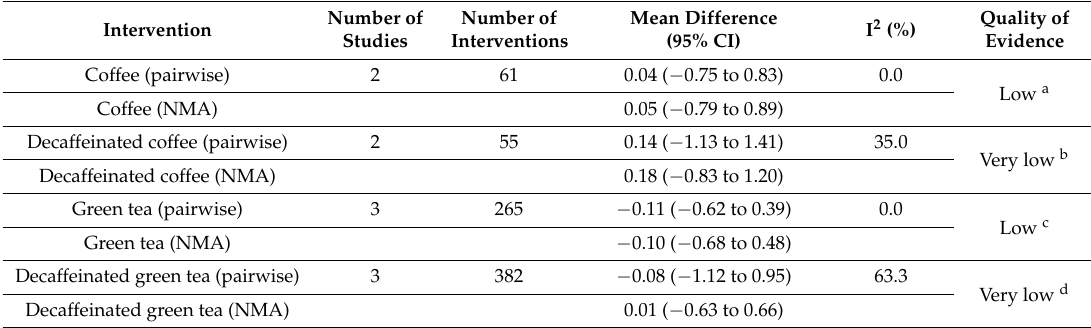
Table 6. Intervention effect on HOMA-IR vs.